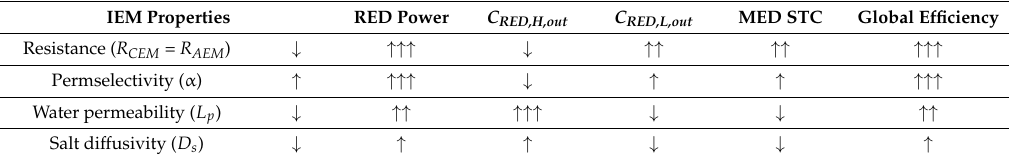
Table 3. Qualitative effect of membrane properties on the performance of RED, MED and RED- MED-HE. IEM Properties RED Power C RED,H,out C RED,L,out MED STC Global Efficiency